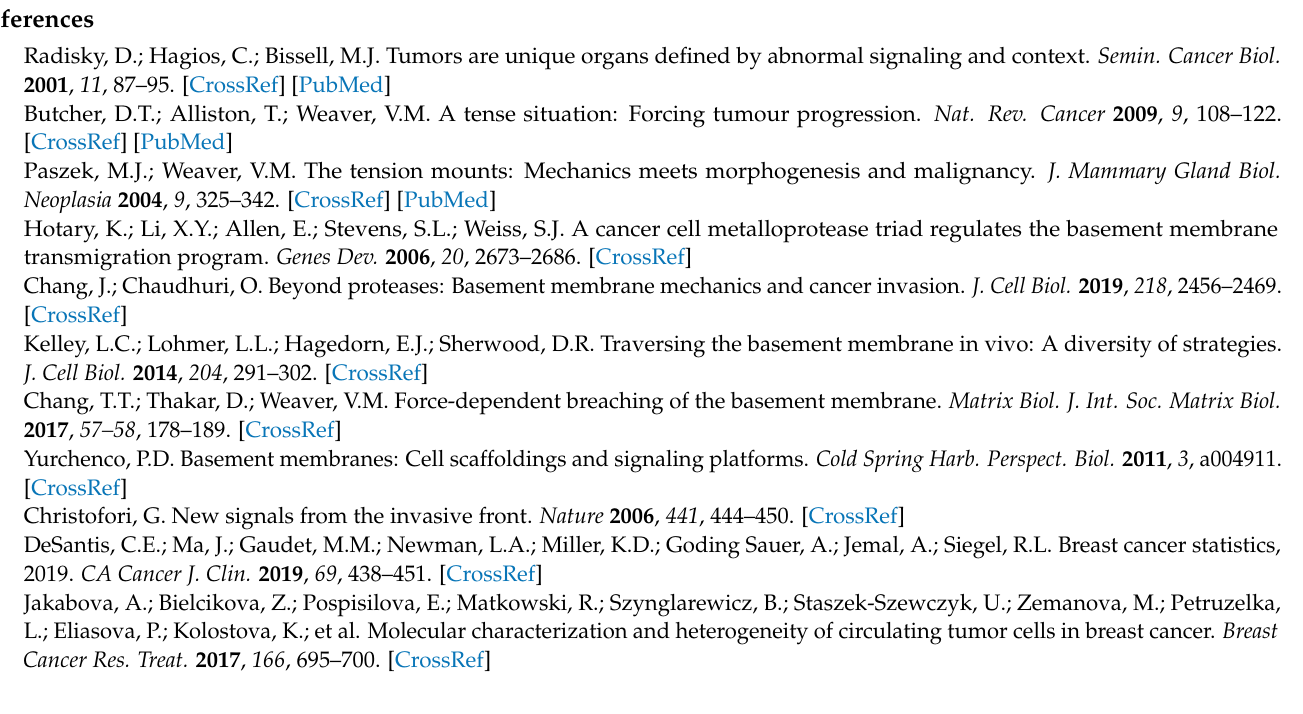
during BM-invasion, Figure S3: Basement membrane traversing cell protrusions, Figure S4: Temporal evolution of the substrate volume displaced by the mechanical activity, Figure S5: Comparison of the mean indented volume during pre-BM transmigration mechanical activity of ld-BM and hd-BM acini; Table S1: Exact invasive fraction values and mean invasion timepoints, Table S2: Exact median strain energy values, Movie S1: Time-lapse sequence over 65 h of the ld-BM acinus on tumour-like (12 kPa) stiffness conditions, shown in Figure 2C,E,G, Movie S2: Time-lapse sequence over 65 h of the hd-BM acinus on normal-like (0.12 kPa) stiffness conditions, shown in Figure 2F,G, Movie S3: ERISM time-lapse investigation of the ld-BM acinus shown in Figure 4E, Movie S4: ERISM time-lapse investigation of the hd-BM acinus shown in Figure 4H, Movie S5: ERISM time-lapse investigation of the ld-BM acinus discussed in Figure